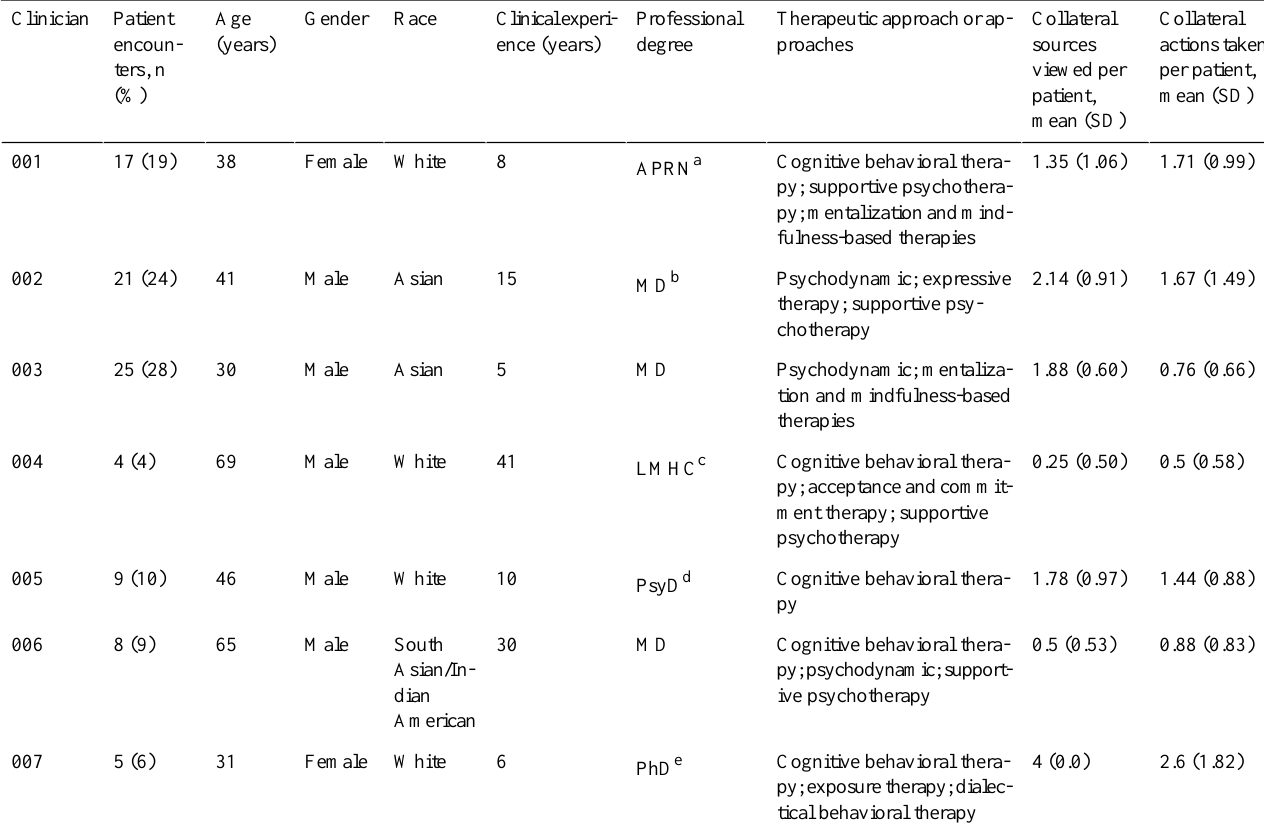
Table 1. Clinician